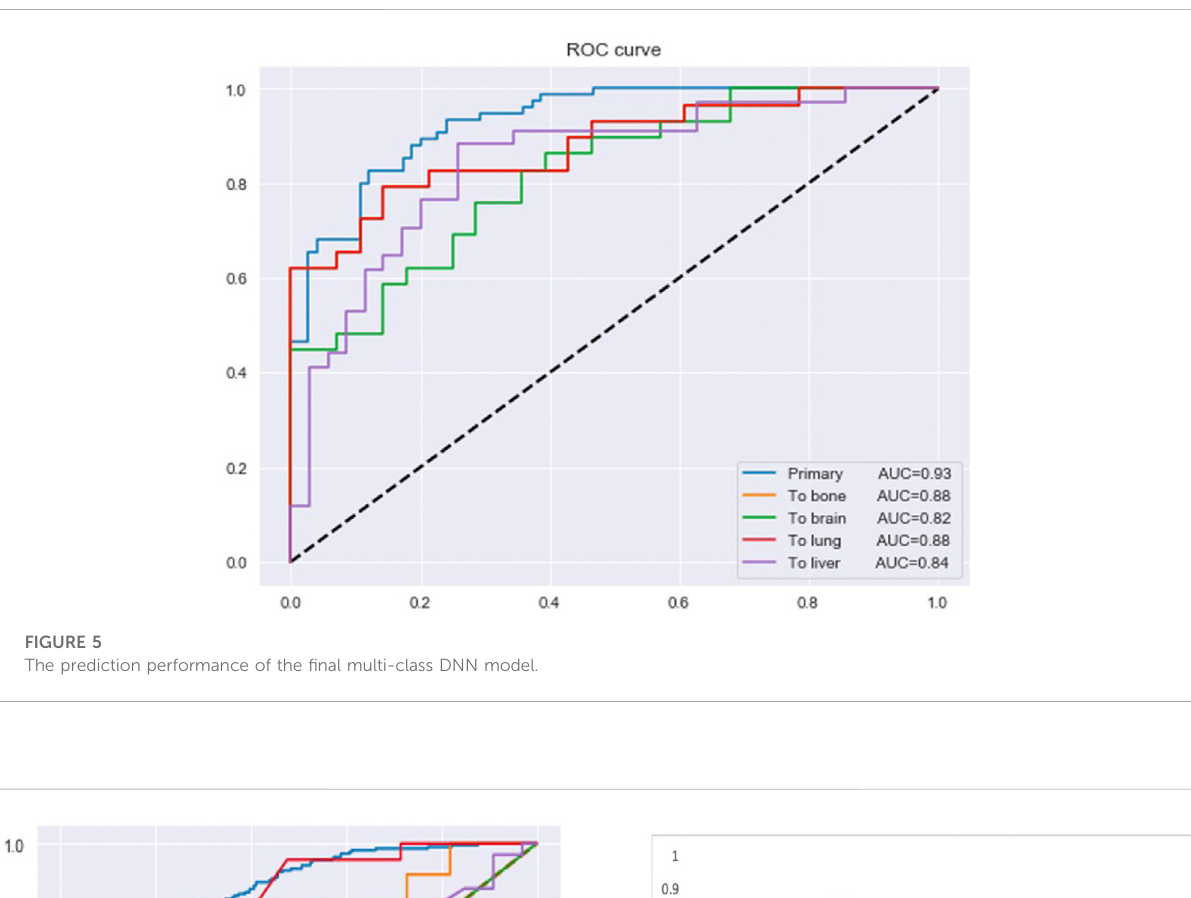
FIGURE 5 The prediction performance of the fi nal multi-class DNN model.